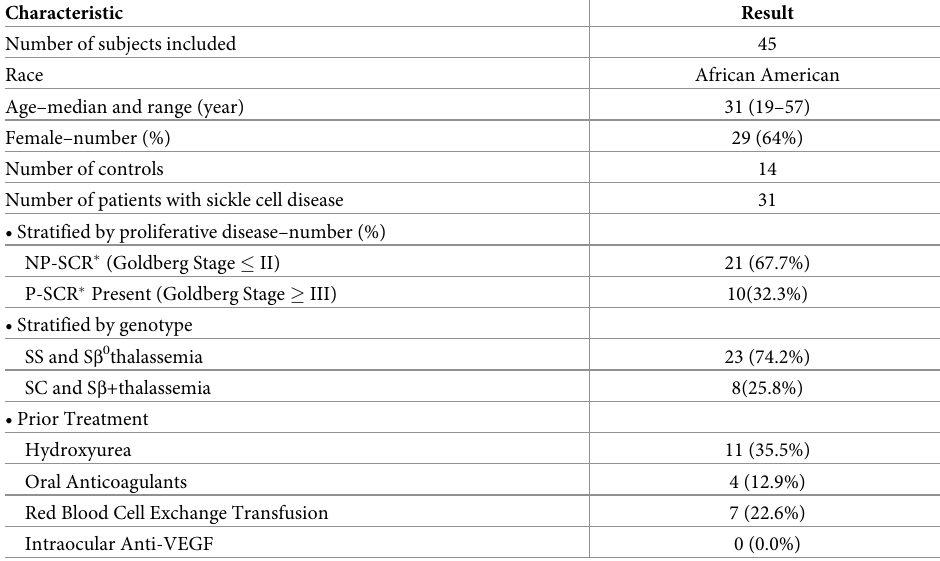
Table 1. Subject characteristics.